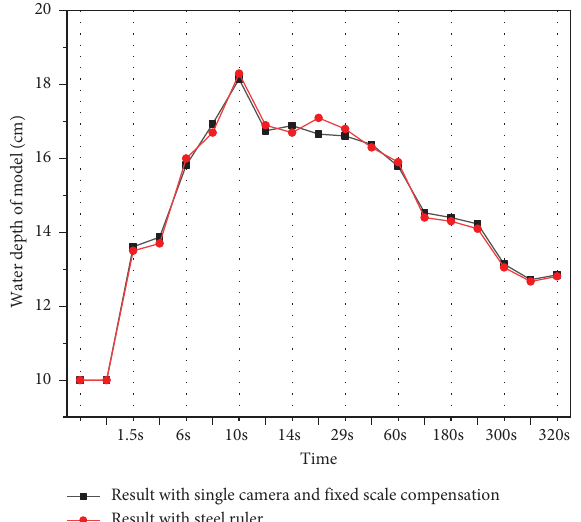
Result with single camera and fixed scale compensation Result with steel ruler Figure 9: Te instantaneous water depth at the unsteady water level at the same position by two measuring methods.